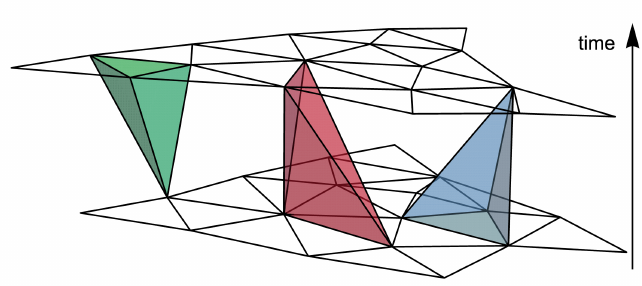
Figure 1. The three distinct types of building blocks in 3D CDT: a 13-simplex (left), a 22-simplex (center), and a 31-simplex (right). By convention, time labels increase in the upwards direction, so that the bottom slice is labeled t and the top slice is labeled t + 1